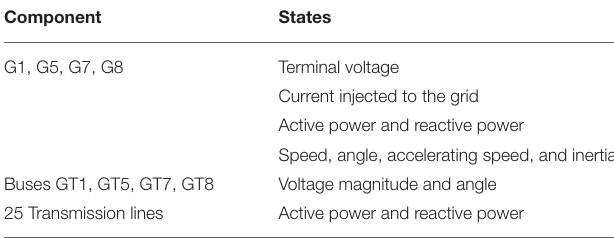
TABLE 8 | Selected key variables in GB